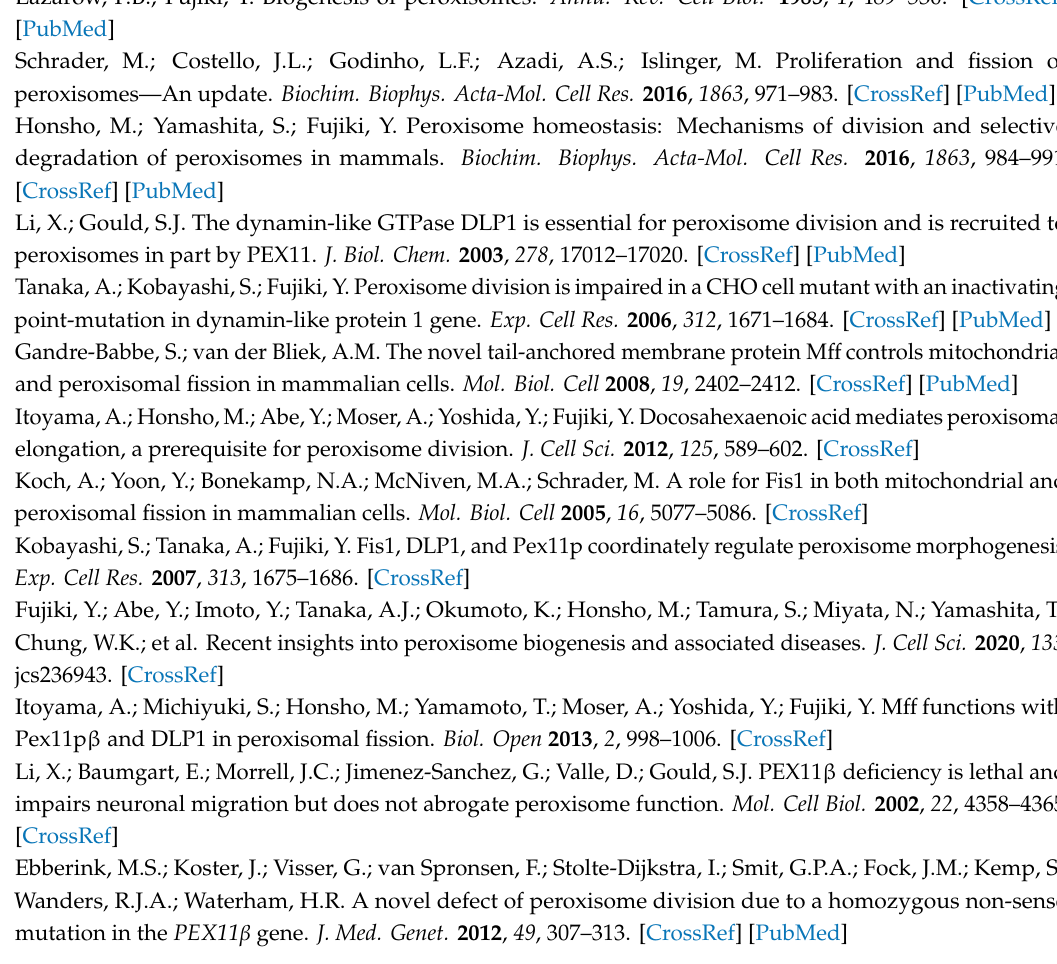
Figure S1: Intracellular distribution of NME3H135N and its membrane